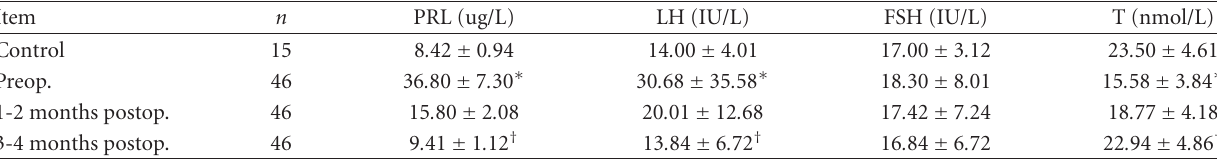
Table 1: Serum pituitary-gonadal hormone levels before and after transplantation in the 46 male ESRD patients and 15 male controls. Item n Control